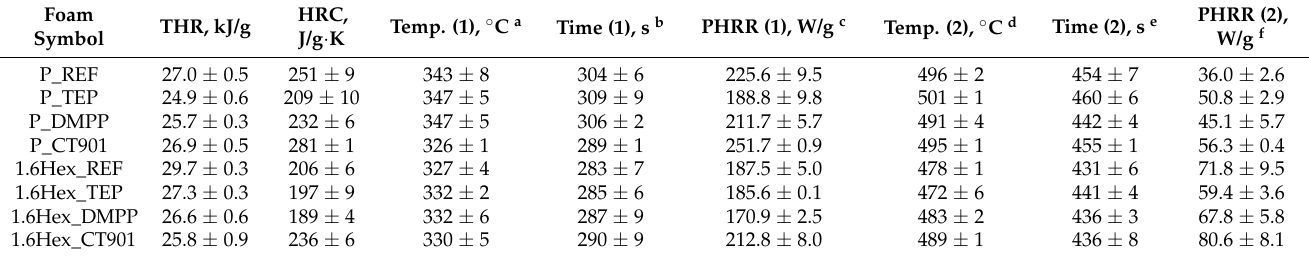
Table 5. Test results for PUR foams on a pyrolysis combustion flow calorimeter.